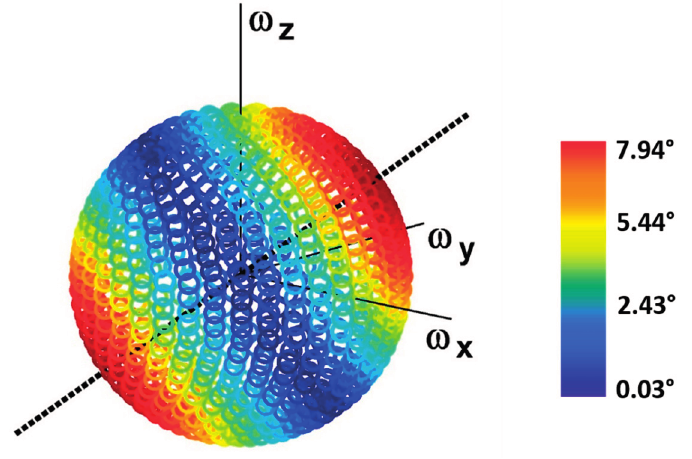
Figure 4. Distribution of the orientation error due to the residual bias RB with equally distributed components across the three axes (directed as the dashed black line in the figure) across the sphere representing different 3D distributions of a constant unit angular velocity vector. The error is represented by a color range, from dark red (maximum values) to dark blue (minimum